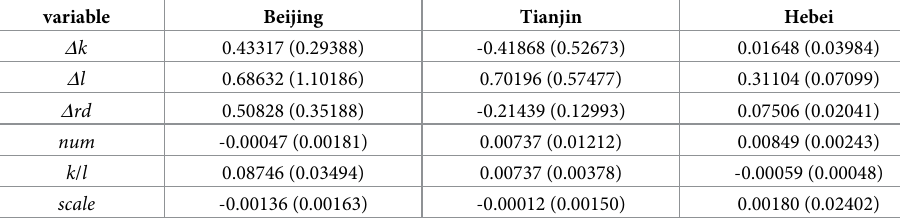
Table 8. Dual difference results of control variables in Beijing, Tianjin and